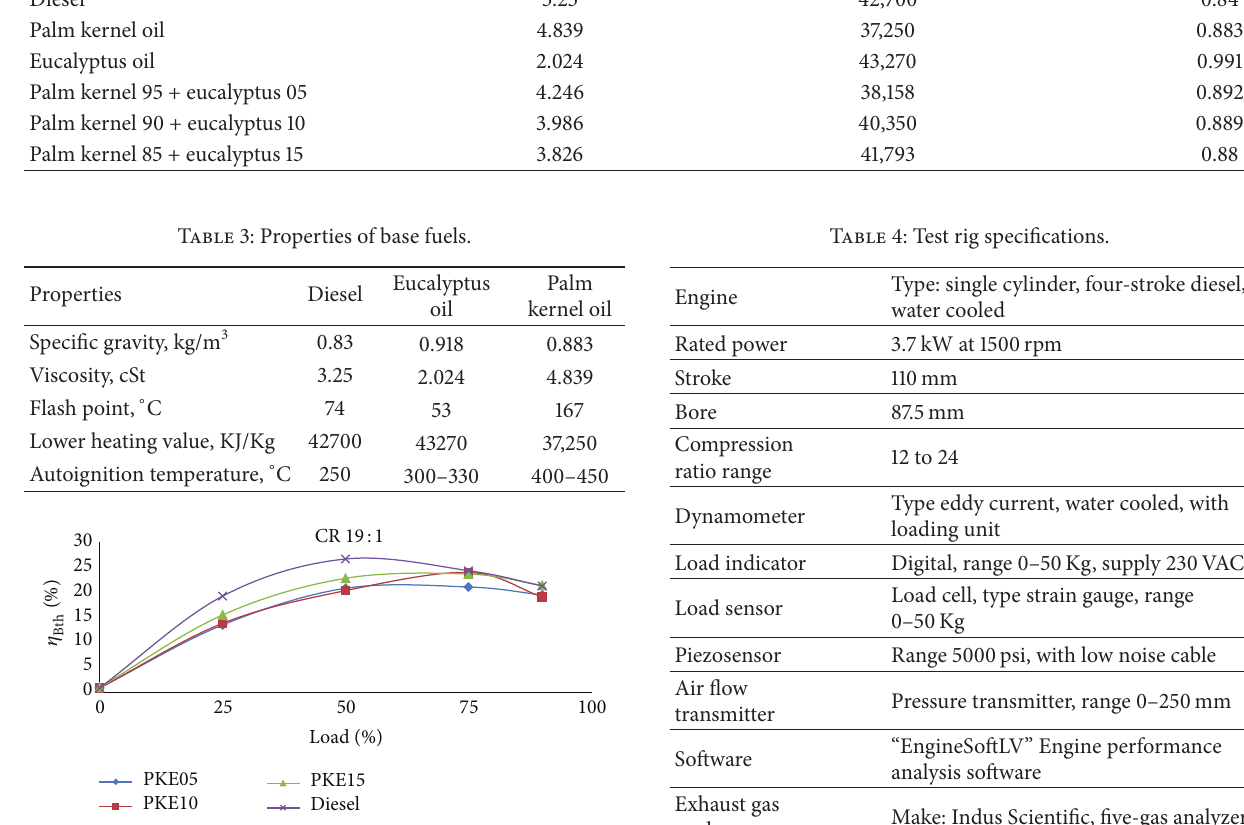
Figure 3: Load versus brake thermal efficiency at 19: 1 CR.